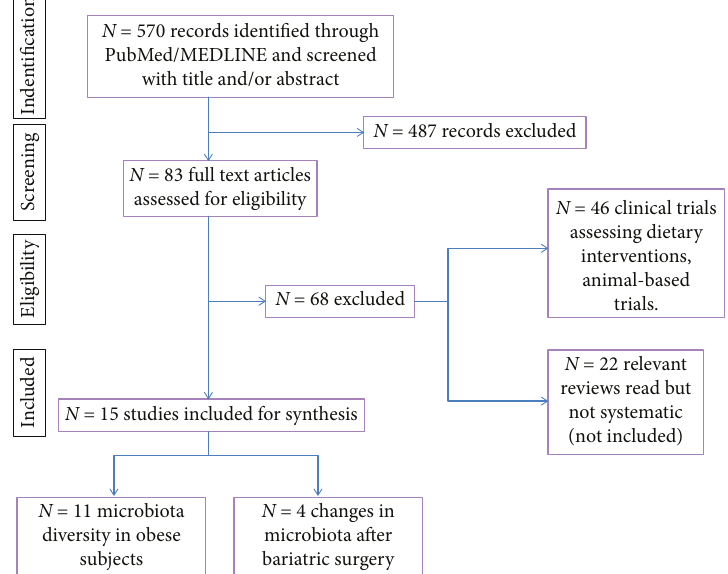
Figure 1: PRISMA fl ow